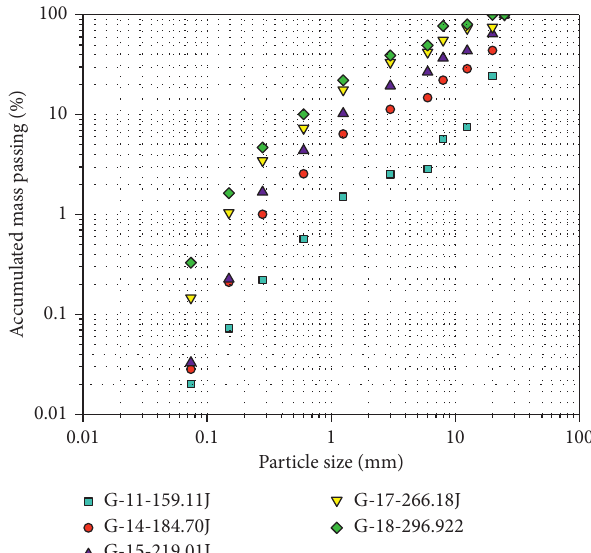
Figure 11: Accumulated mass passing (%) versus particle size (mm) in the coordinate of